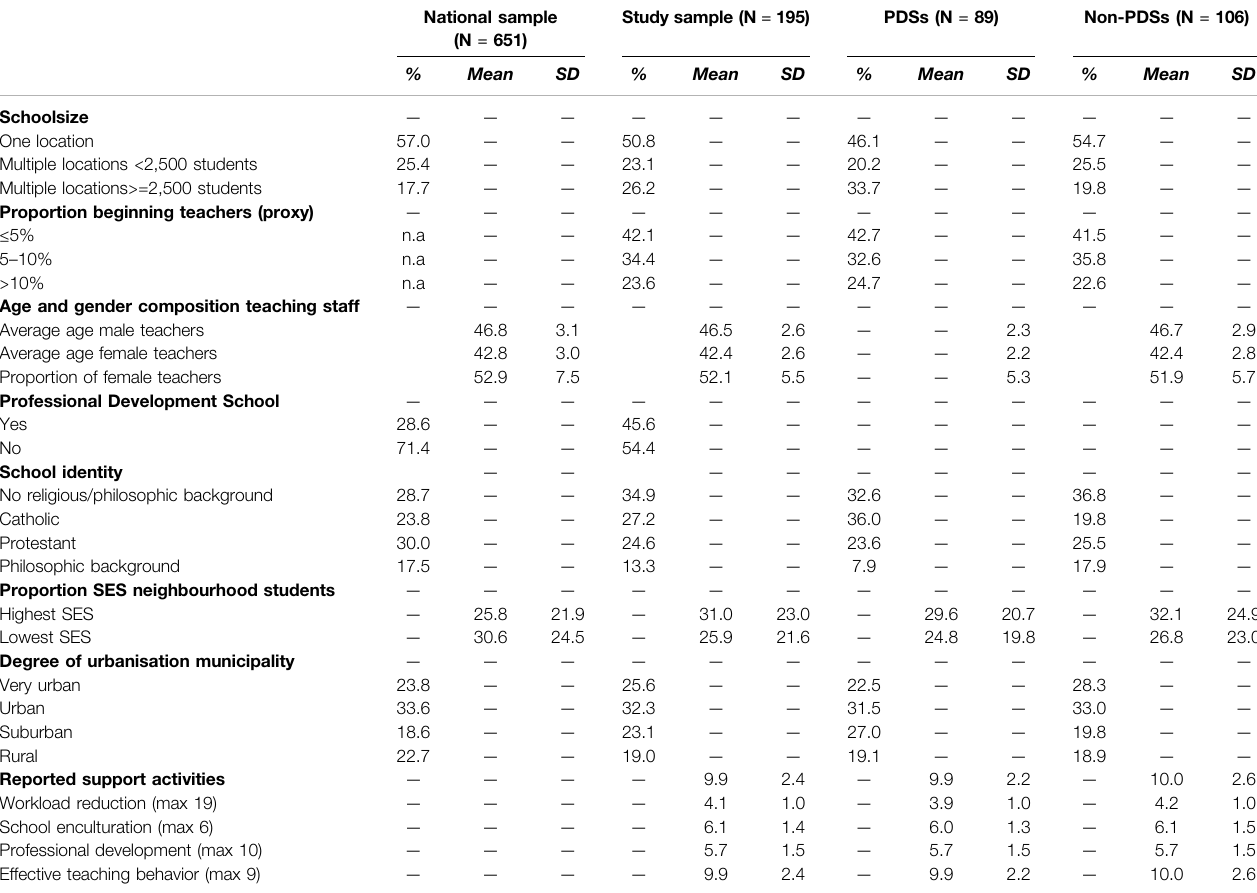
TABLE 1 | School characteristics and reported support activities, national and study sample, strati fi ed by PDSs and